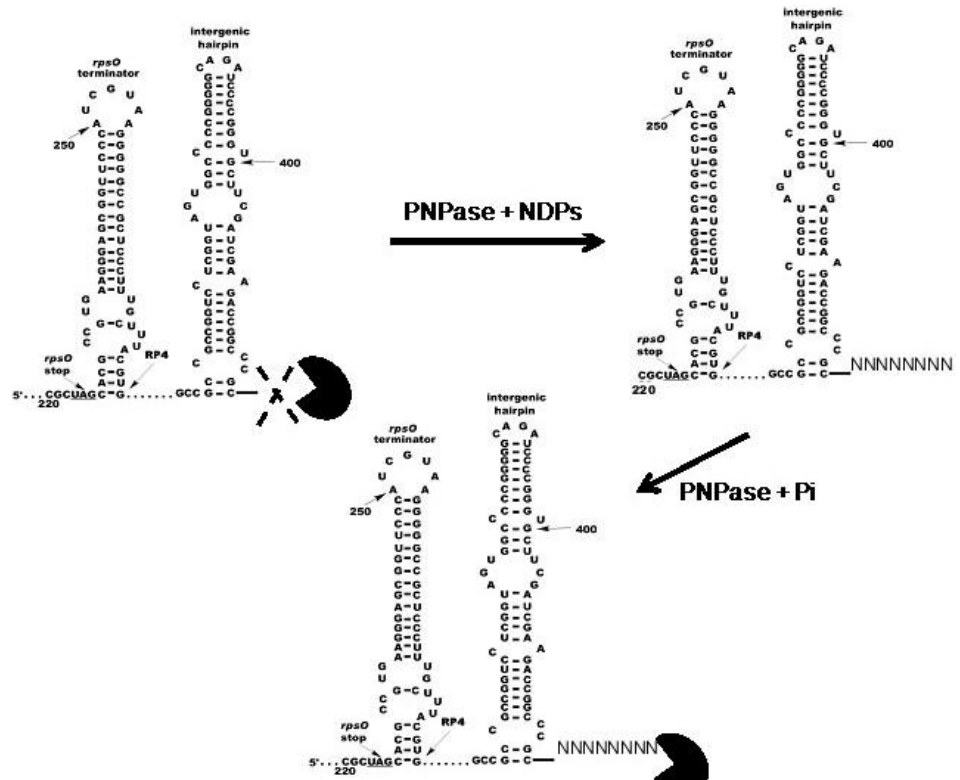
Figure 5. Model for the effects of NDPs on the activity S. coelicolor PNPase. The model posits that S. coelicolor PNPase (PacMan symbol) is able to phosphorolyze 5650 and other structured substrates to a limited extent in the absence of NDPs, as indicated by the dashed X. In the presence of NDPs, PNPase synthesizes unstructured 3′-tails in vivo, and these tails then provide an anchor for the enzyme, thus facilitating the digestion of structured substrates. Copyright © American Society for